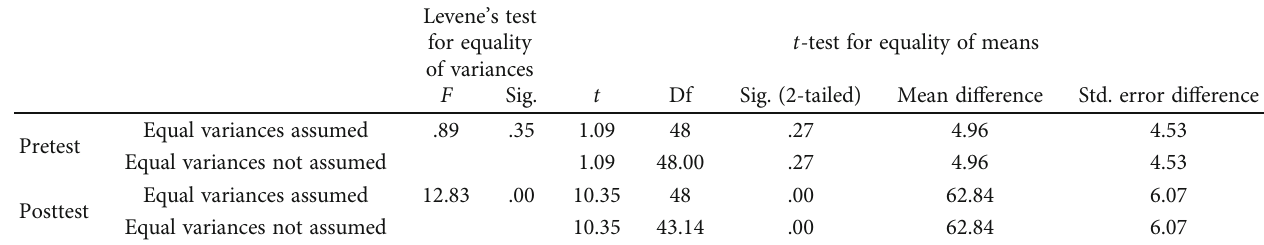
Table 9: Independent sample t -test of both groups in the anxiety pretests and posttests. Levene ’ s test for